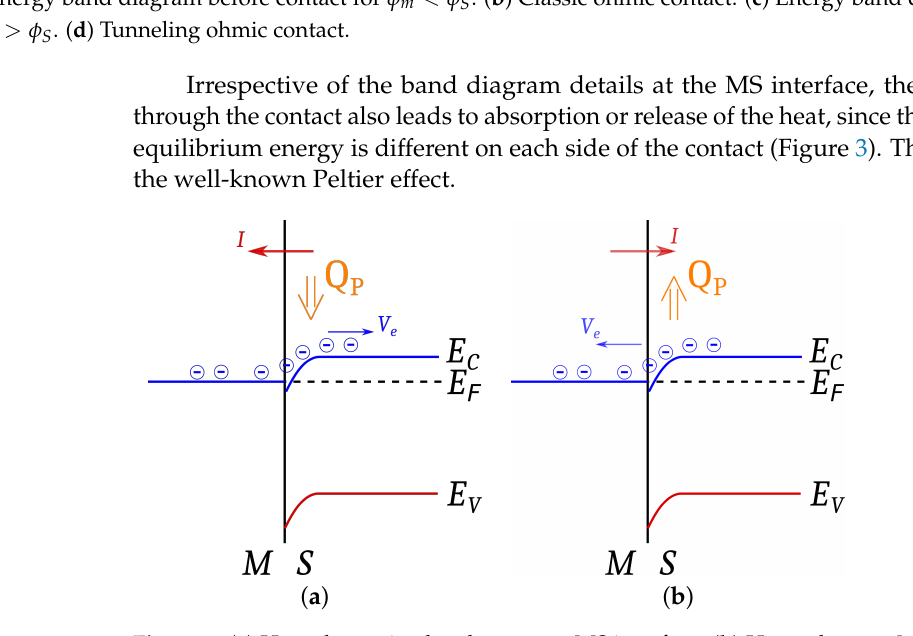
Figure 3. ( a ) Heat absorption by electrons at MS interface. ( b ) Heat release at MS